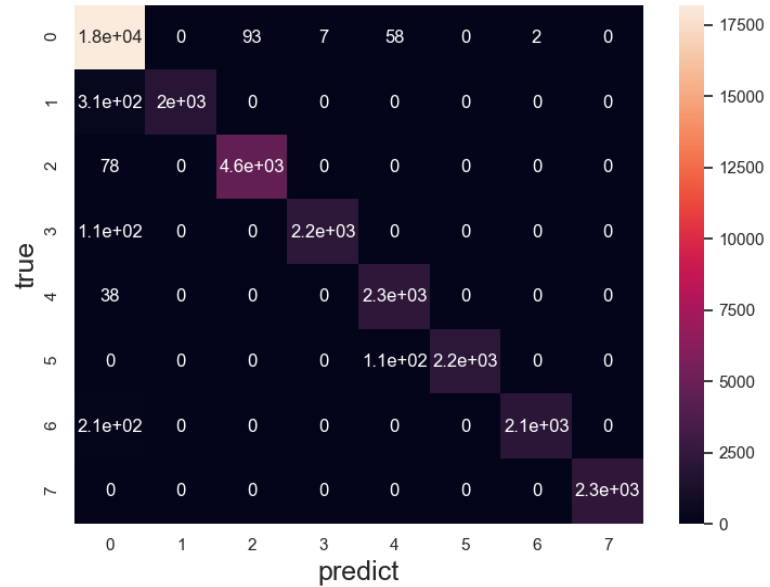
Figure 7. Confusion matrix of the test set.